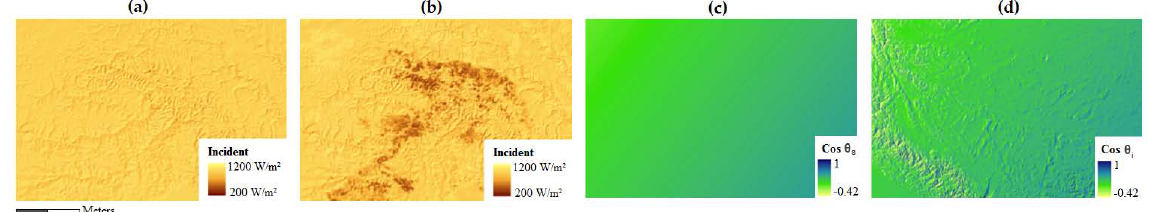
Figure 4. Surface irradiance computed using: ( a ) a constant atmospheric transmission factor or ( b ) the proposed methodology and the solar geometry expressed as: ( c ) the solar zenith angle or ( d ) the sun incident